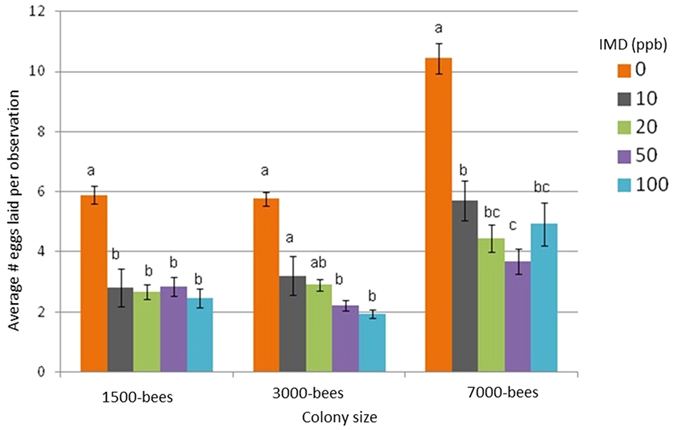
Average (SE) number of eggs laid by queens per 15 minute observation period pooled over three week chronic exposure of imidacloprid (IMD) (0, 10, 20 50, and 100 ppb) in 1500-, 3000-, and 7000-bee colonies ((dose*size*week) interaction: F16,1053 = 0.93; p = 0.54; (dose*size) interaction: F8,1053 = 6.17; p < 0.0001).Different letters denotes significant statistical differences among treatment levels within each colony size at α < 0.05. Results indicate that queens in untreated colonies laid significantly more eggs than queens in treated colonies at all colony sizes.